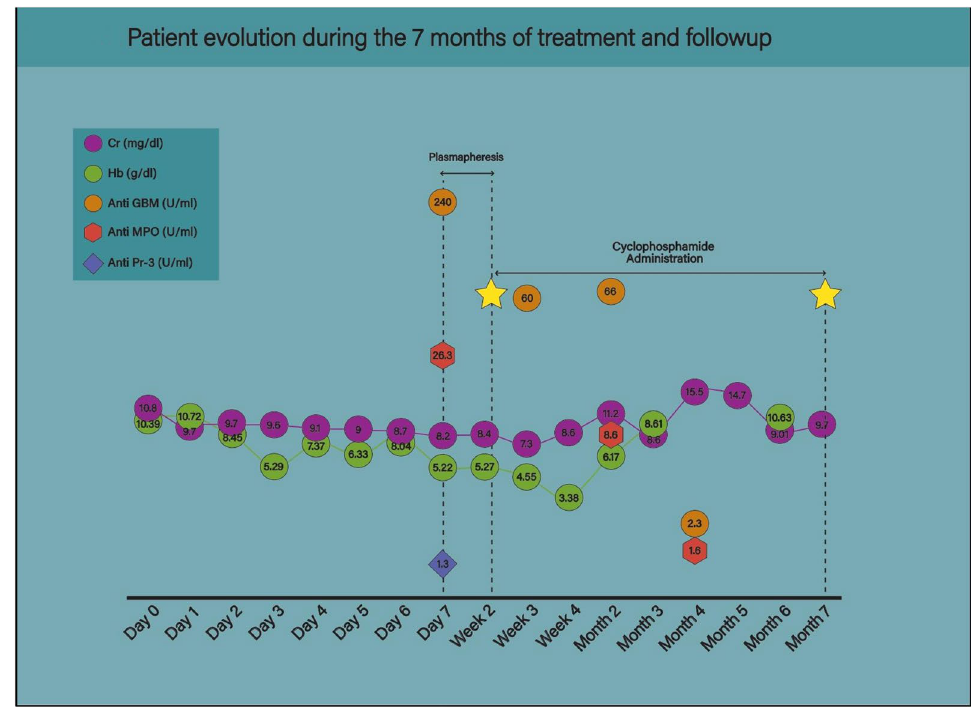
Fig. 3 Graph showing patient’s evolution during the 7 months of treatment and follow‑up, taking into account serum creatinine, hemoglobin, anti‑GBM, anti‑Mpo, and